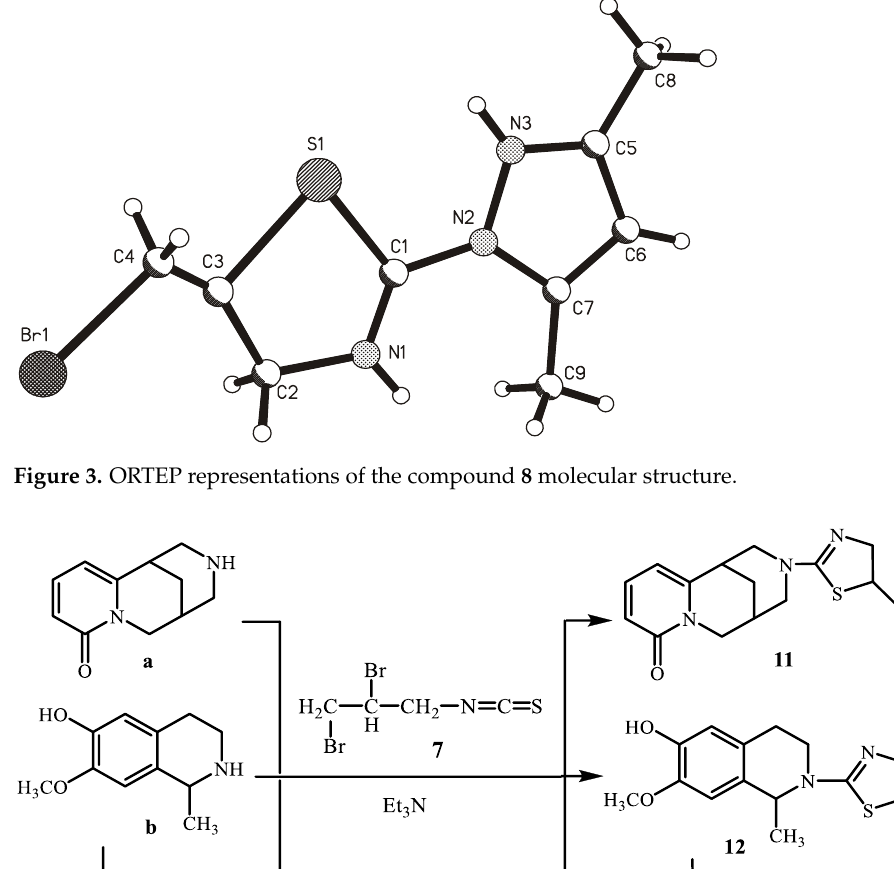
Figure 3. ORTEP representations of the compound 8 molecular structure.